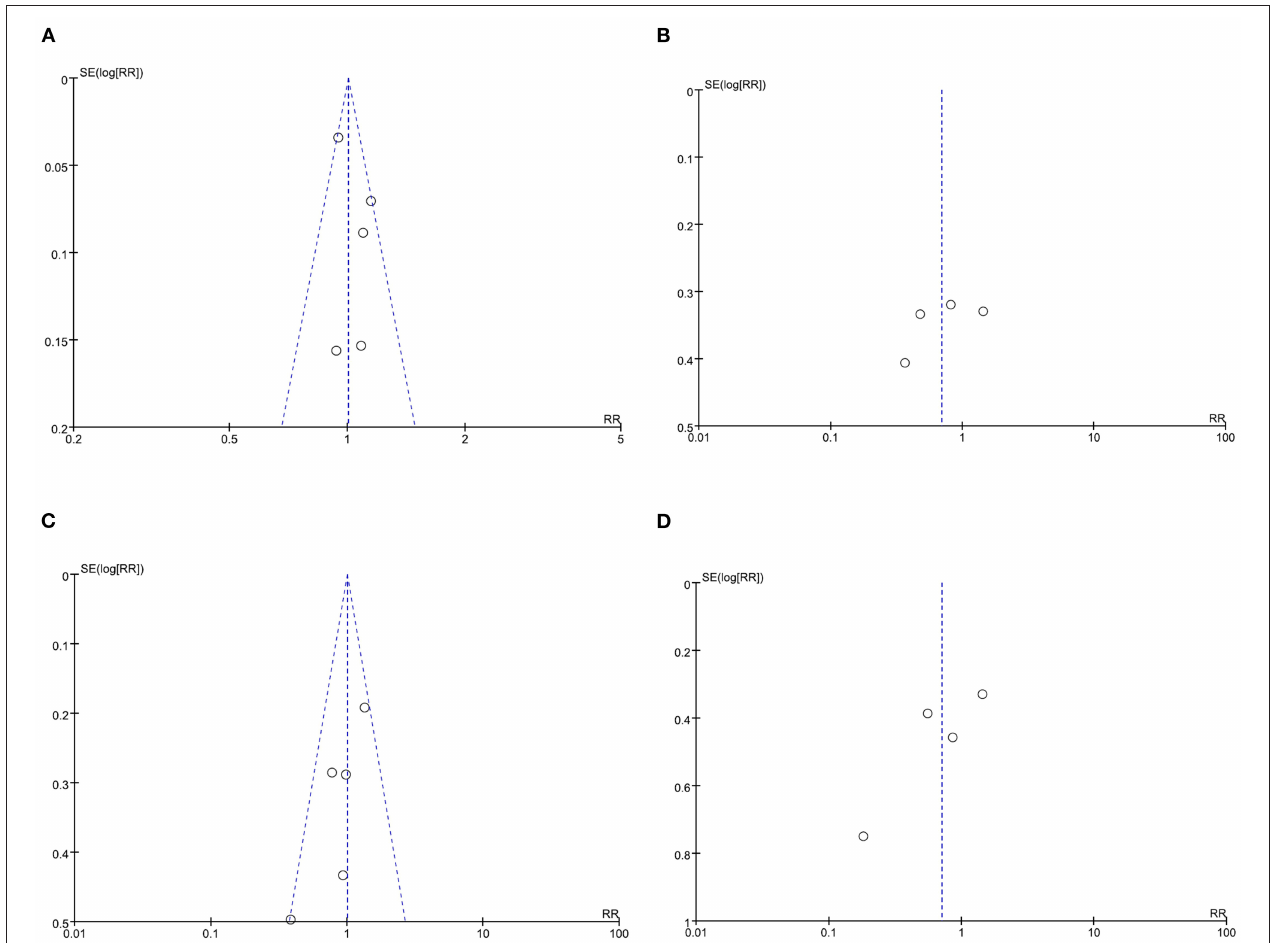
FIGURE 9 | Funnel plots demonstrate the publication bias. (A) Funnel plot for the outcome primary success at 6 months; (B) Funnel plot for the outcome postoperative PVR occurrence; (C) Funnel plot for the outcome number of patients who underwent vitreoretinal reoperations; (D) Funnel plot for the outcome number of vitreoretinal reoperations due to postoperative